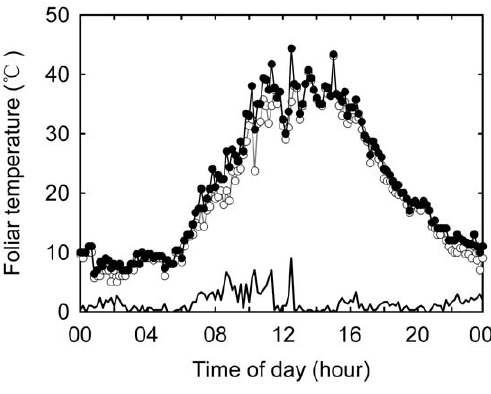
Figure 3. Representative 24-h foliar temperature ( T leaf ) profiles from Stipa krylovii Roshev. grown in the control (open) and warming (filled) plots during the field measurement cam- paigns. Thick solid line indicates warming-induced changes in T leaf between control and warming plots.